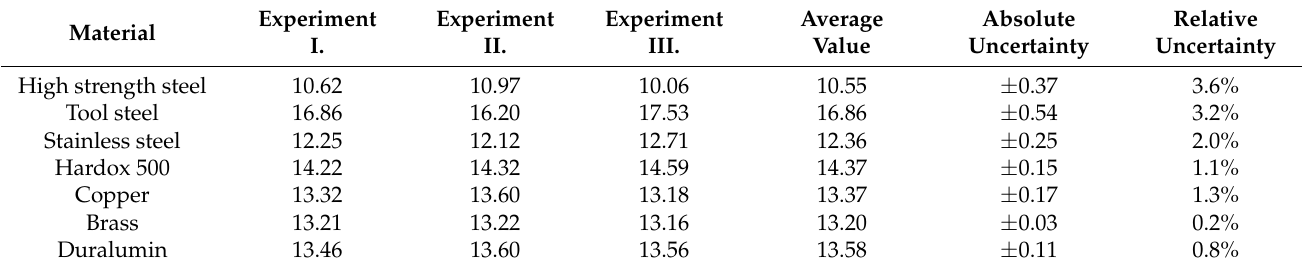
Figure 2. Non-ferrous metals and the respective average angles—the order from the left to the right (WRN norm): copper (2.0060), brass (2.0402), duralumin (3.1325). Table 6. The declination angles measured for experimental samples in degrees (10 measurements for each case). Experiment Material Material High strength steel Tool steel Stainless steel